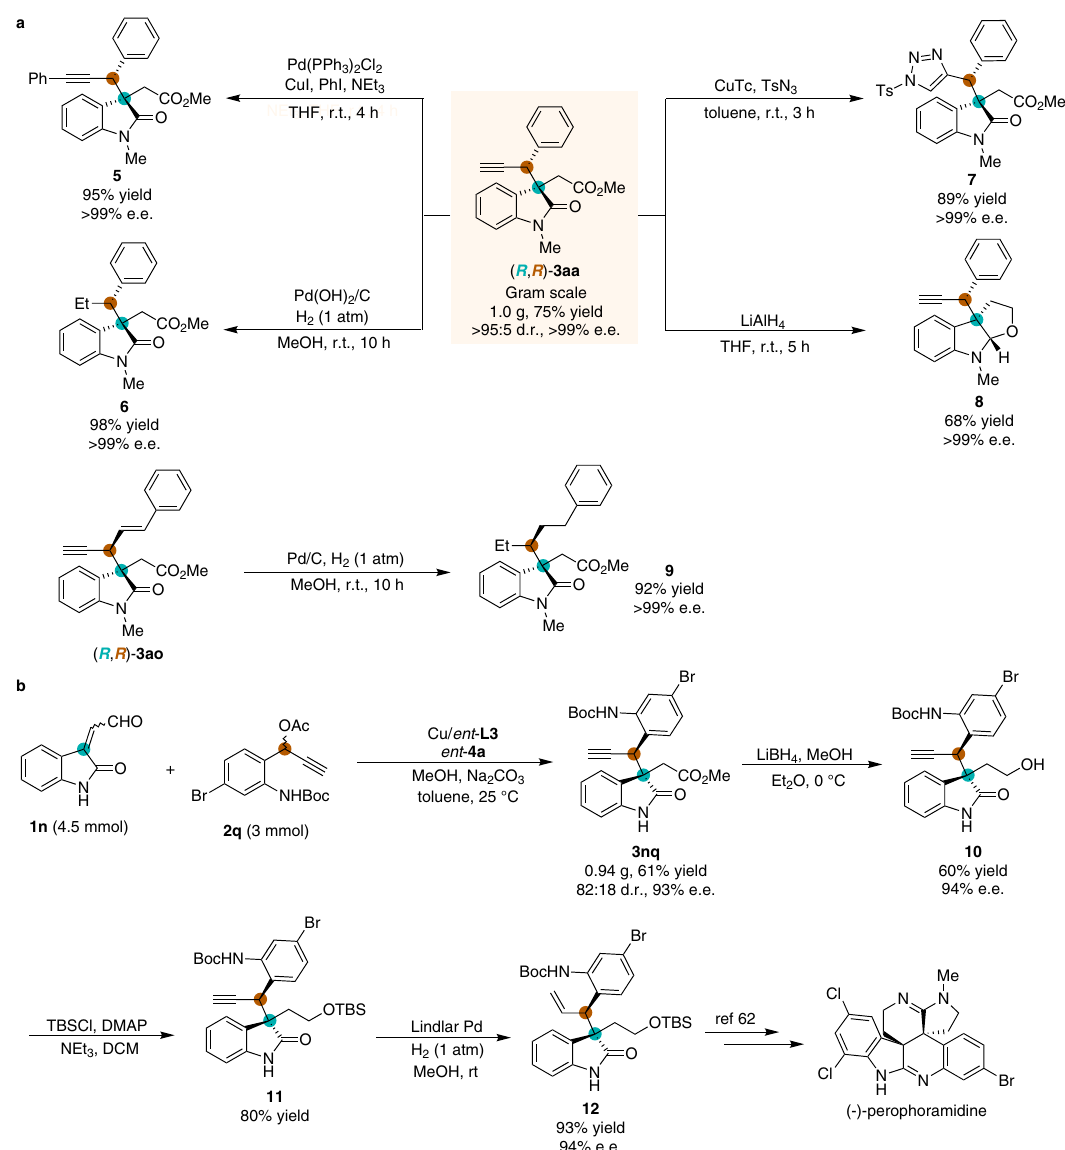
Fig. 7 Scale-up reaction and synthetic transformations. a Gram-scale process and functional group transformations. b Preparation of synthetic precursors for (-)-perophoramidine. See Supplementary Information for experimental